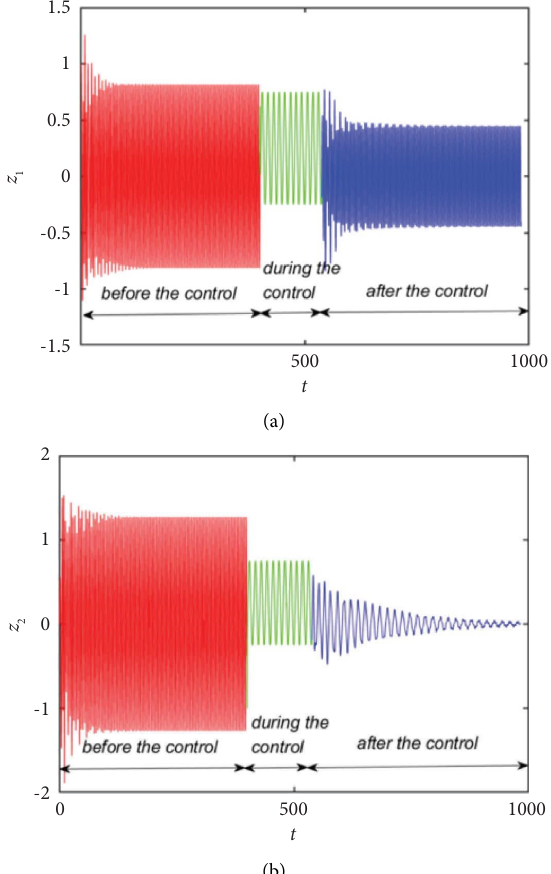
Figure 10: Te time history of the system responses under the OLPNCL control. (a) Te mechanical equipment vibration response. (b) Te NES vibration